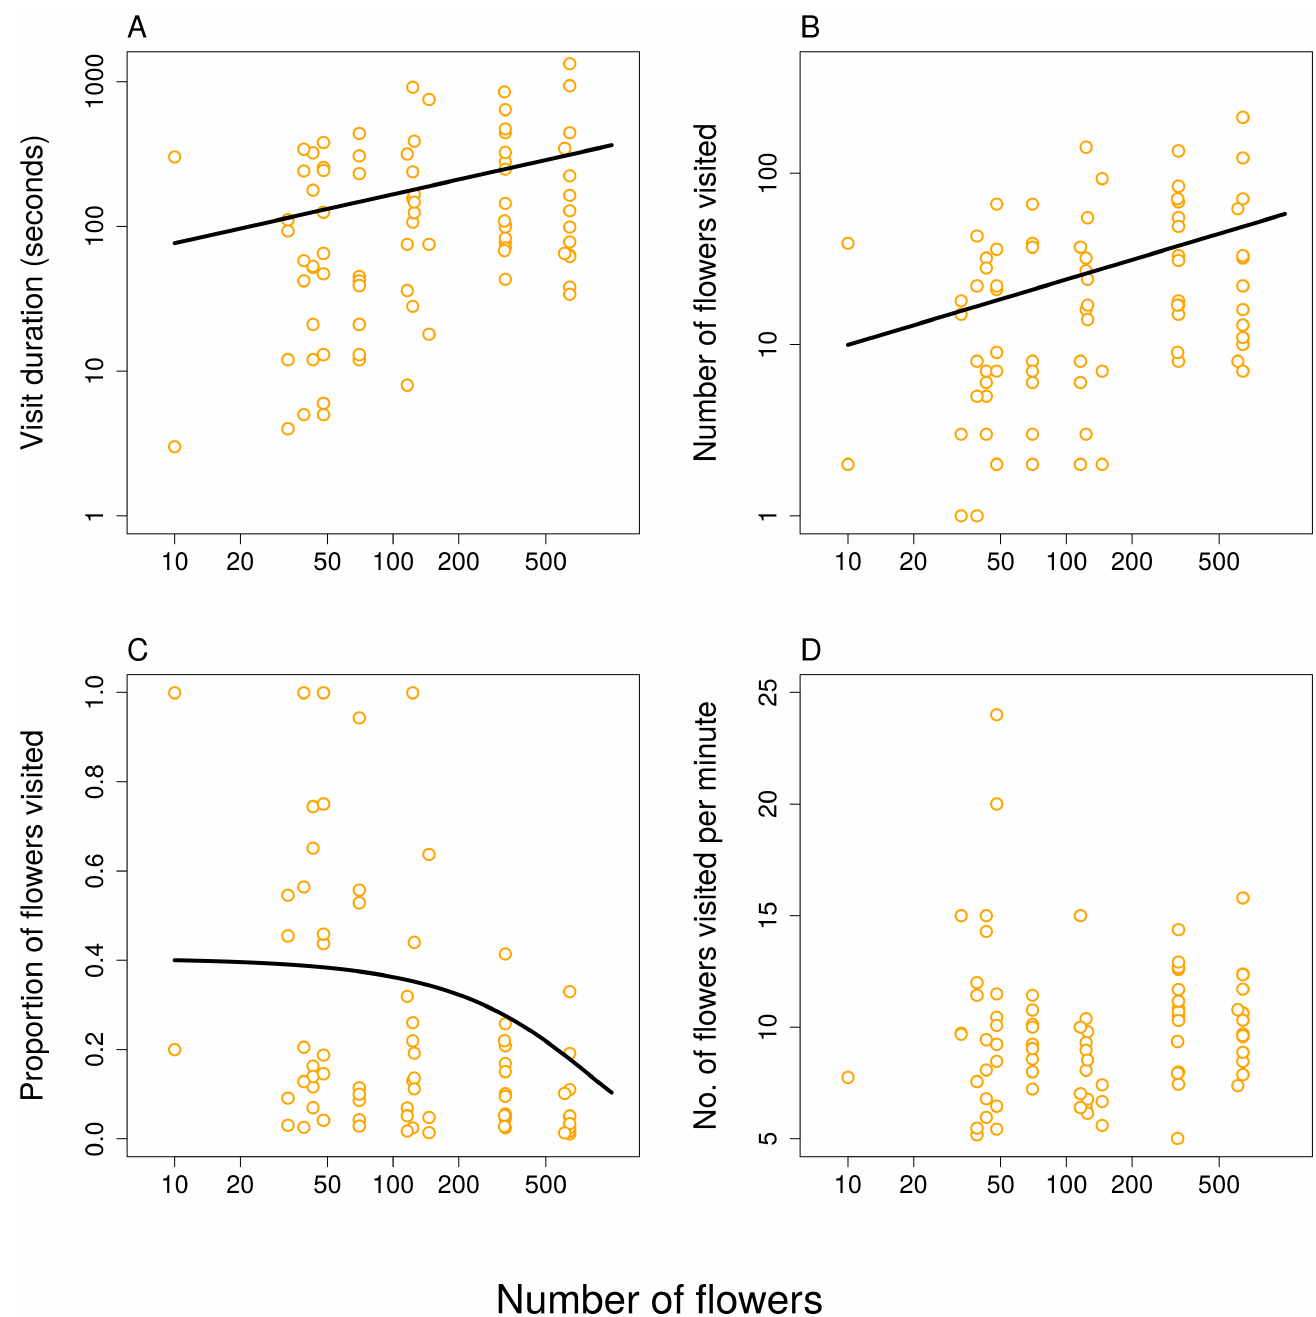
Fig 2. Foraging behaviour of honeybees in response to the number of flowers in clusters of multiple plants. A: The time spent foragingwithin the cluster by individualhoneybees increasedwith the number of flowers available. B: The numberof flowers visited increasedwith the total numberof flowers available.C: The proportionof flowers visited by individual bees decreased with the number of flowers available. D: The number of flowers exploitedper minute did not show any significantrelationship to the number of flowers available.X-axis in A.—D. and y-axis in A. and B. are on a log-